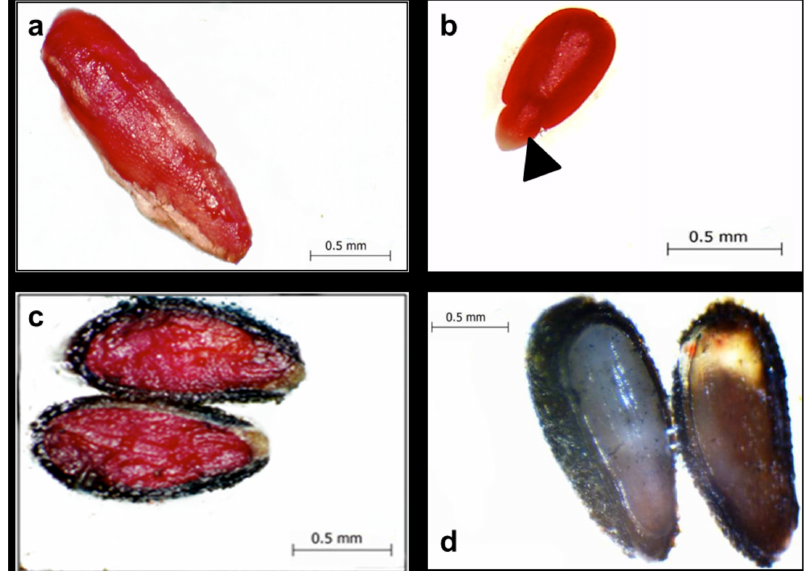
Fig. 3: Pictures of stereoscopic microscope. Tetrazolium test viability of the embryos developing inside the lemon balm seeds (scale bar = 0.5 mm). (A) Viable endosperm and embryo stained in red without the seed coat, strain 7/2013, (B) strain 7/2014. (C) Longitudinal section through viable seeds lemon balm with embryo stained in red, strain 28/2013. (D) Longitudinal section through the dead seed lemon balm with non coloured embryo, strain 33 / II /